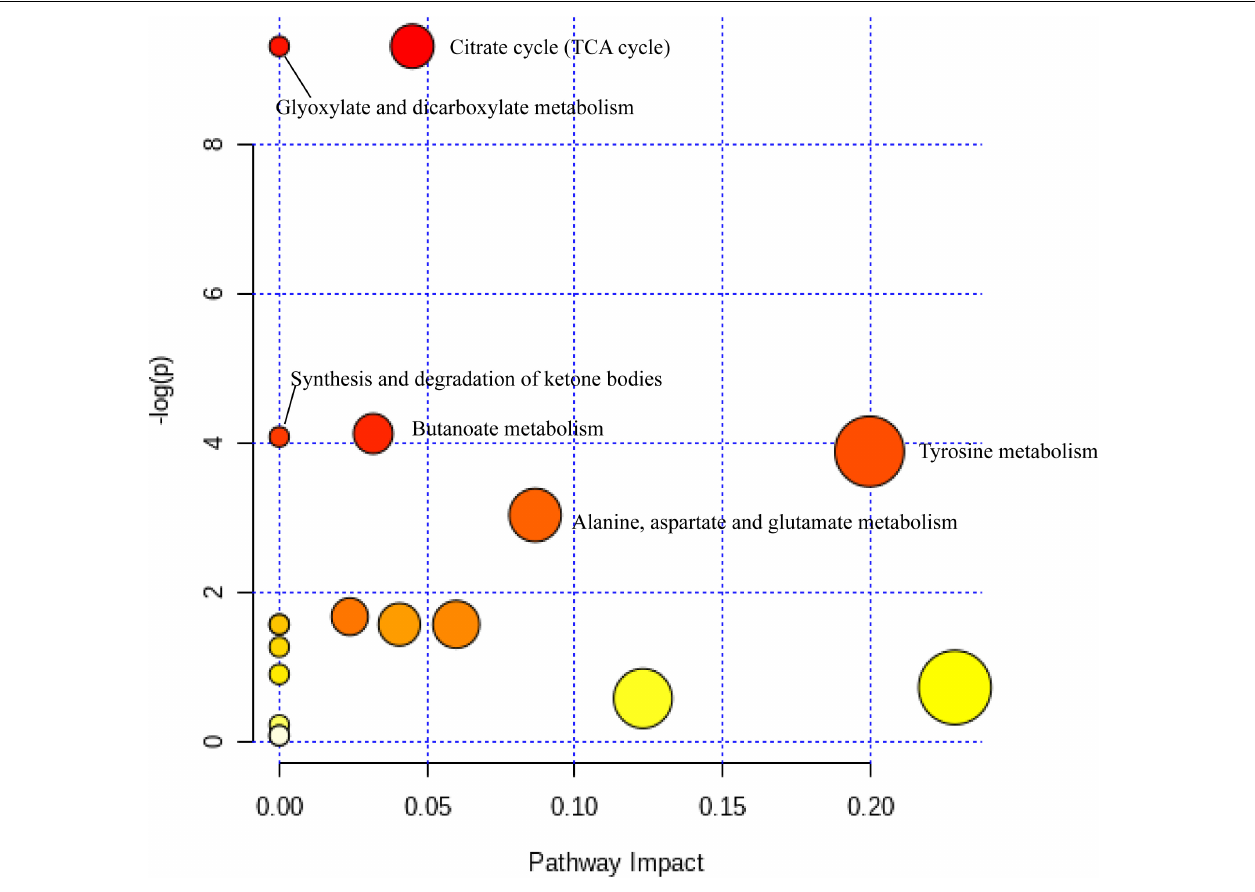
FIGURE 5 | Metabolome view map of the differentially expressed metabolites identified. The deep color shows higher pathway impact values; the larger size demonstrates higher pathway enrichment.